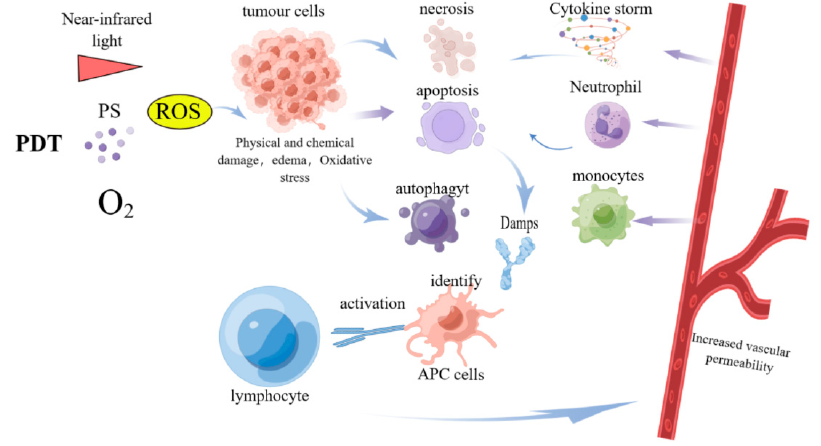
Figure 1. PDT-Induced Immune Effects.